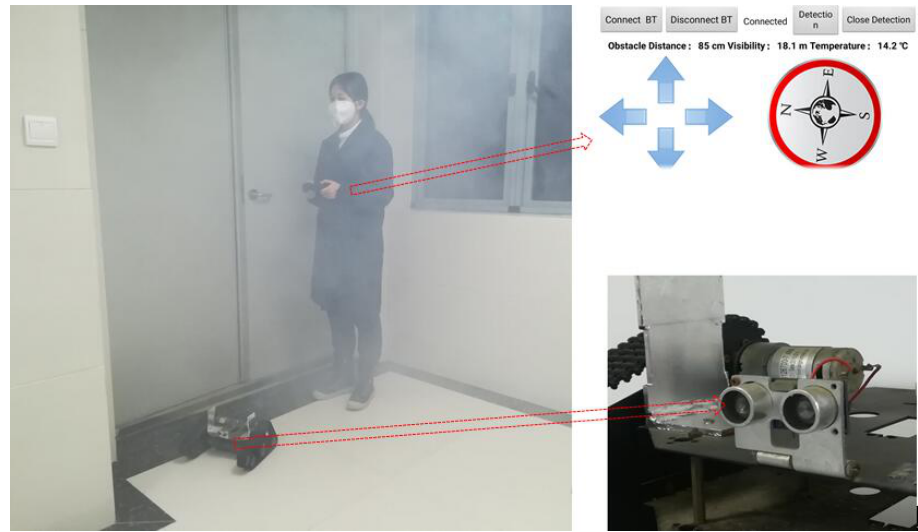
Figure 1. Guided vehicle guides the walking under fire conditions ( left ), which includes the distance measurement module ( bottom right ) and remote-control system ( upper right ).